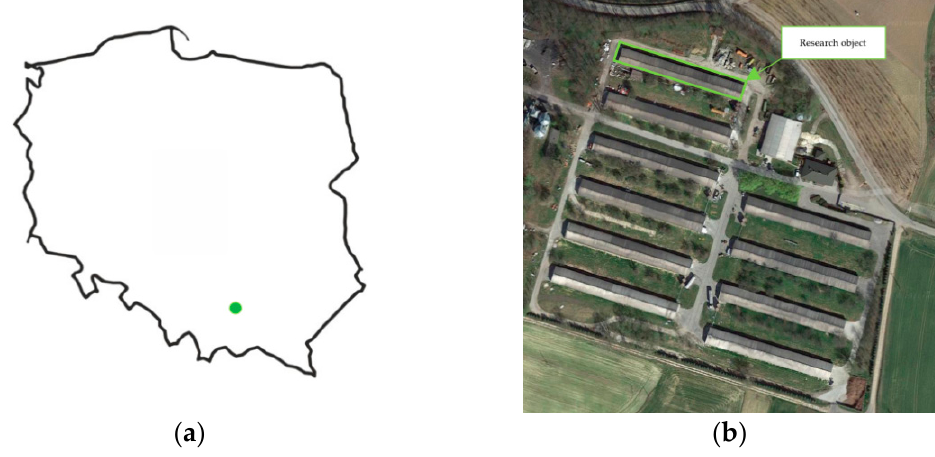
Figure 1. Location of the study site in Poland ( a ) and satellite image ( b ).